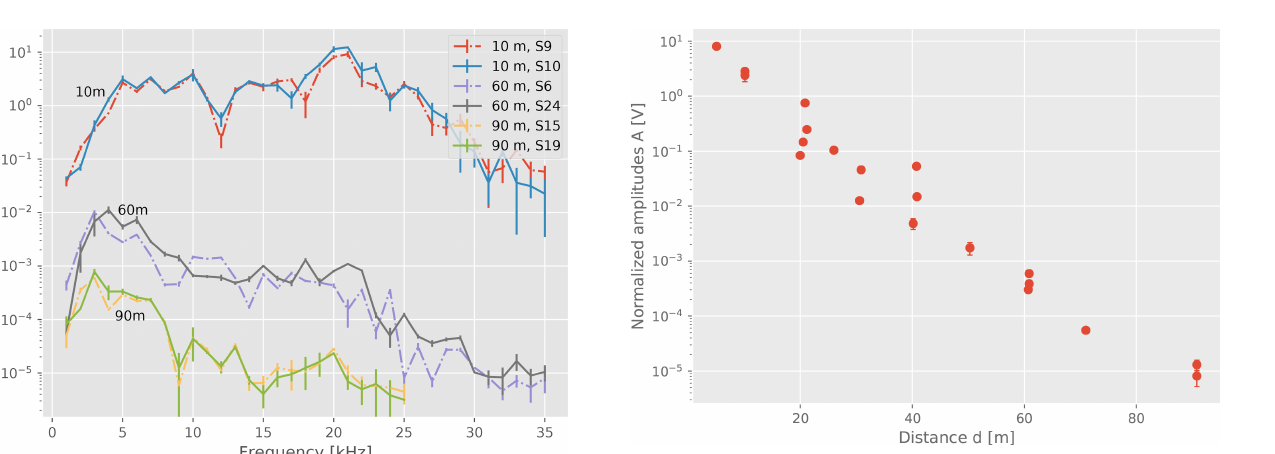
Figure 8. Amplitudes of measurement series 9 and 10 (10m), 6 and 24 (60m), and 15 and 19 (90m).